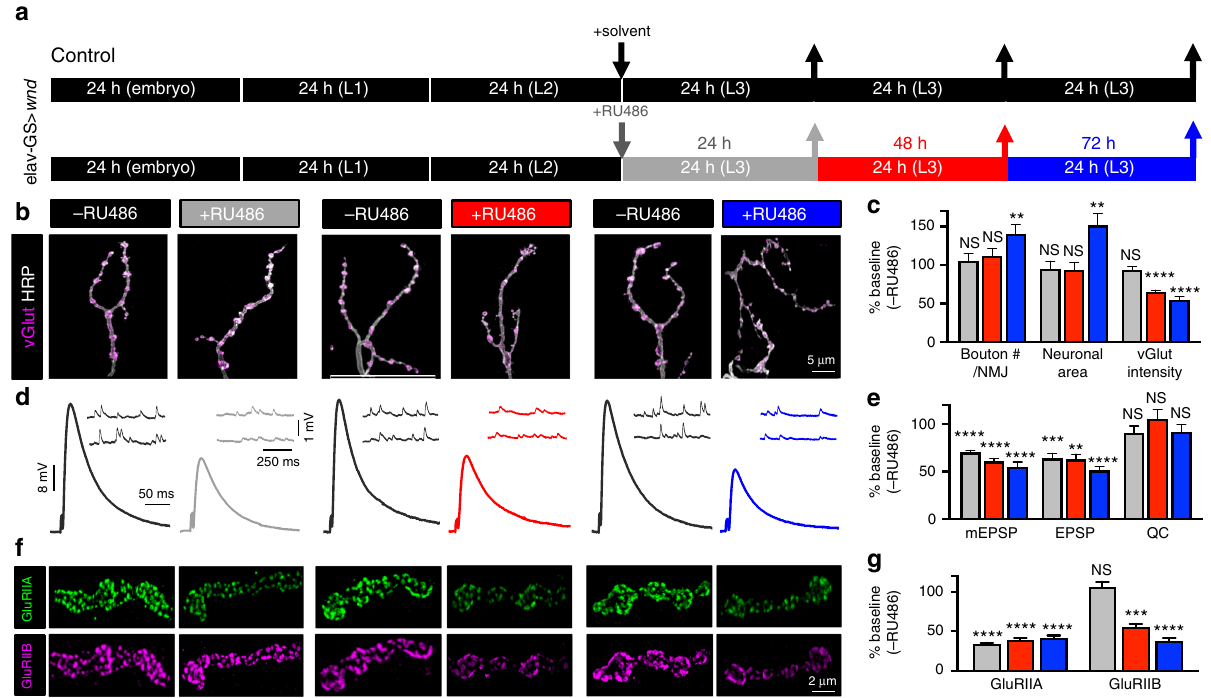
Fig. 2 Acute activation of neuronal wnd signaling rapidly induces GluR remodeling without impacting presynaptic growth or structure. a Schematic illustrating the temporal administration of RU486 to acutely induce neuronal wnd expression in late stages of larval development. Control genotypes ( UAS-wnd/ + ; elav-GS/ + ) were reared in the same conditions but fed saline without RU486, while experimental animals where fed RU486 at the indicated time points. Staining and electrophysiological experiments were performed after 24h (gray), 48h (red), and 72h (blue) following exposure to RU486. b Representative images of NMJs immunostained with antibodies that recognize the synaptic vesicle marker vGlut (vesicular glutamate transporter; magenta) and the neuronal membrane marker HRP (white). c Quanti fi cation of total bouton number per NMJ, neuronal membrane surface area, and vGlut intensity levels normalized to control (larvae at the same time points raised on fl y food without RU486). d Representative mEPSP and EPSP traces from NMJs in the indicated genotypes and conditions. e Acute activation of neuronal wnd signaling induces reductions in mEPSP and EPSP amplitudes, but no change in quantal content. f Representative images NMJs in the indicated conditions immunostained with antibodies against two postsynaptic glutamate receptor subunits (GluRIIA and GluRIIB). g Quanti fi cation of total fl uorescence intensity of each GluRIIA or GluRIIB puncta normalized to baseline (same time point without RU486) reveals acute activation of neuronal wnd signaling rapidly remodels postsynaptic GluR levels. Error bars indicate±SEM. One-way analysis of variance (ANOVA) test was performed, followed by a Tukey ’ s multiple-comparison test. * p 0.05; ** p 0.01; *** p 0.001; **** p = 0.0001, NS not signi fi cant, p >